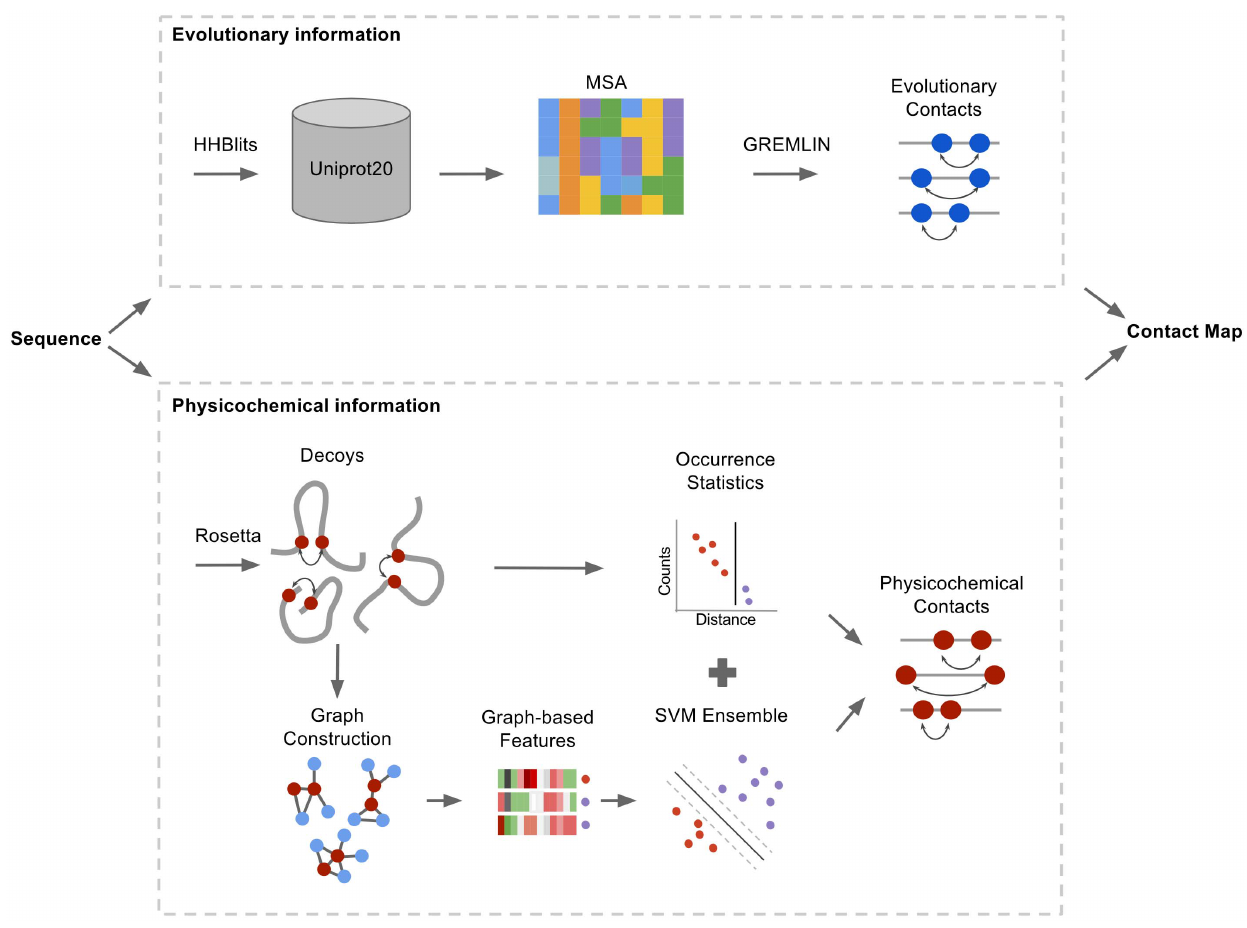
Figure 1. Flowchart overview of EPC-map, combining evolutionary information (upper box) and physicochemical information (lower box). For evolutionary contact prediction, multiple-sequence alignments are constructed by searching the Uniprot20 database with HHblits. GREMLIN is then used to predict contacts from the alignments. For physicochemical contact prediction, decoys are generated with Rosetta. From each decoy, contact graphs are constructed and feature input vectors computed. An SVM ensemble predicts the contact probability from each feature vector. The SVM probability and occurrence statistics predict physicochemical contacts. Lastly, evolutionary and physicochemical contact prediction are combined to form the output of EPC-map.